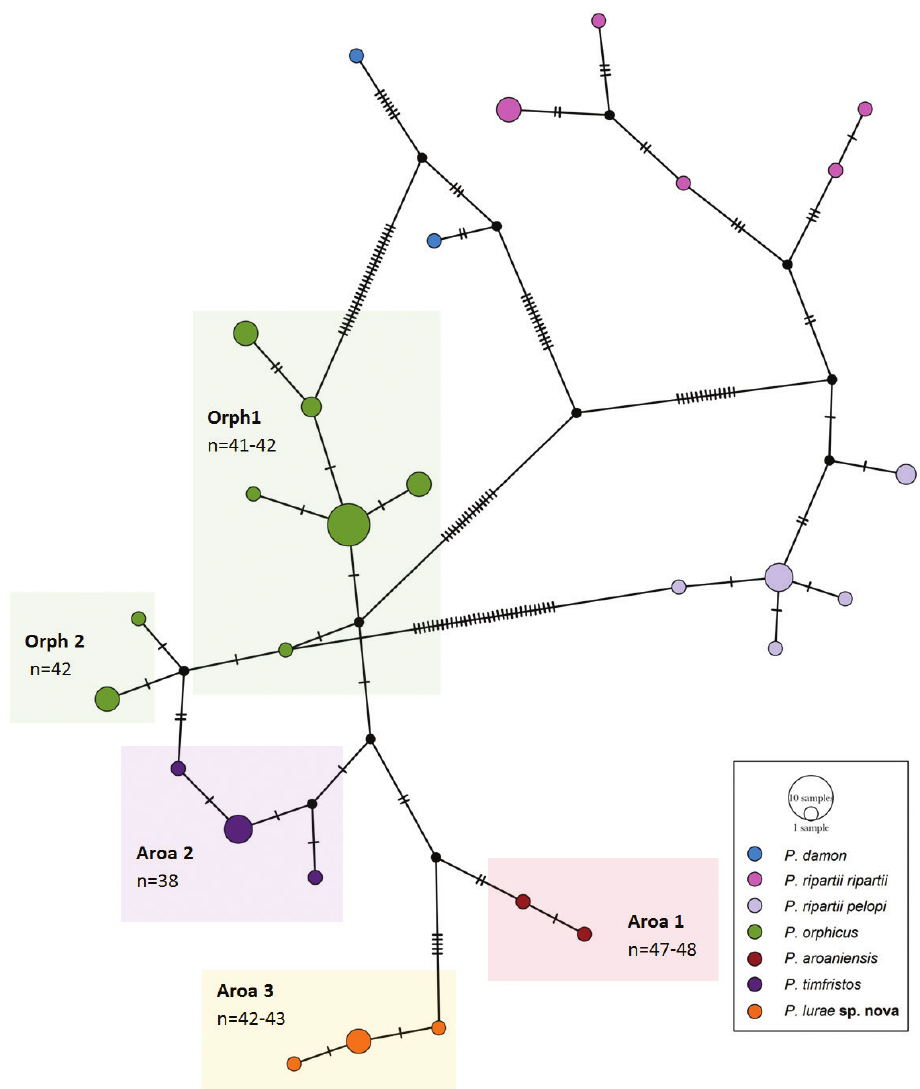
Figure 3. Haplotype network of the P. aroaniensis species group in relation to P. damon and P. ripartii . Coloured circles represent different taxa, as indicated in the legend; coloured boxes delimitate the haplogroups discussed in the text. Each line segment represents a mutation step, and black small circles represent “missing”